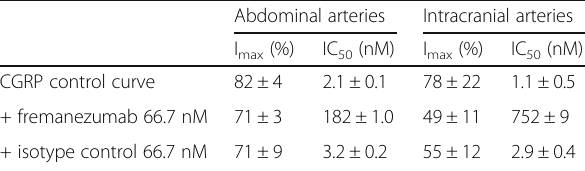
Table 1 Relaxant responses to CGRP in the presence or absence of 66.7 nM fremanezumab or its isotype